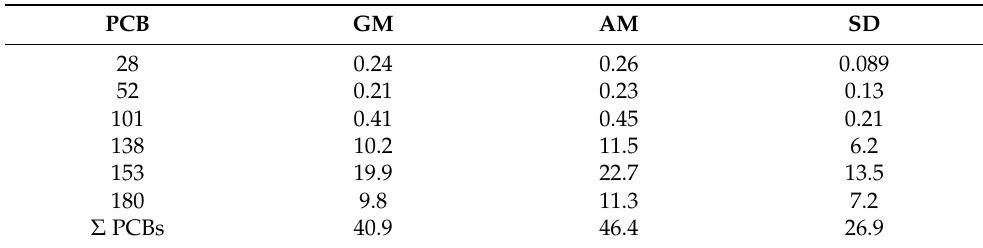
Table 3. Statistical values (GM, AM, SD) of six PCB congeners and their sum in egg content of loggerhead sea turtles expressed as ng g − 1 of